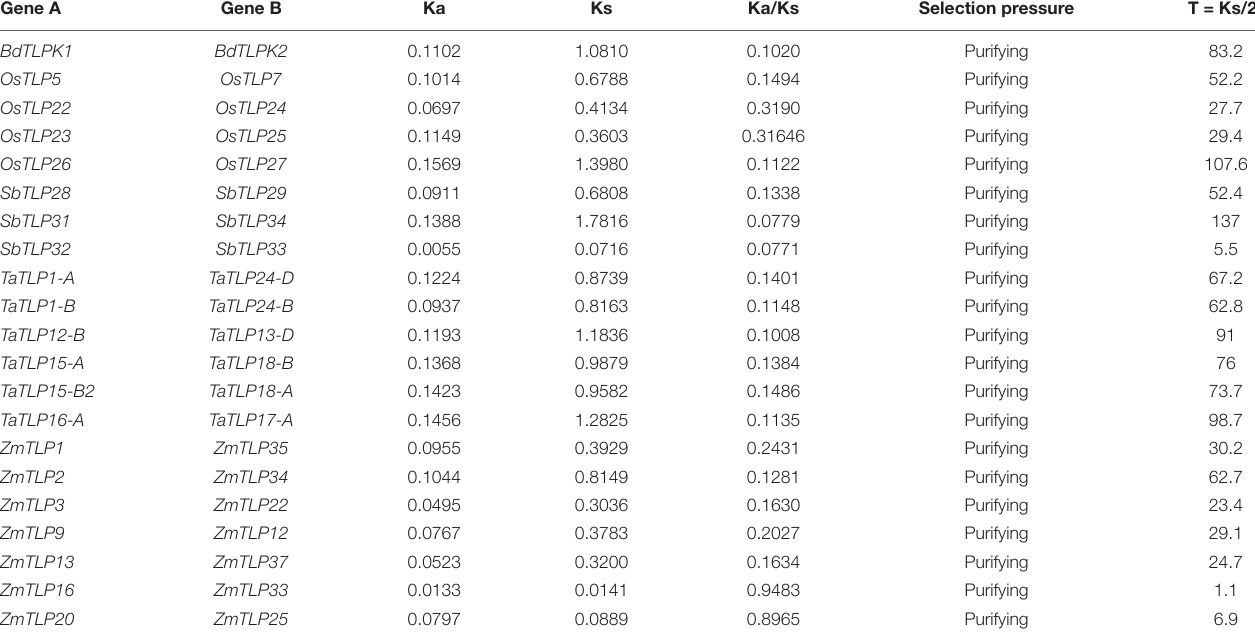
TABLE 1 | The Ka/Ks ratio and divergence time of duplicated TLP gene pairs. Gene A Gene B Ka Ks Ka/Ks